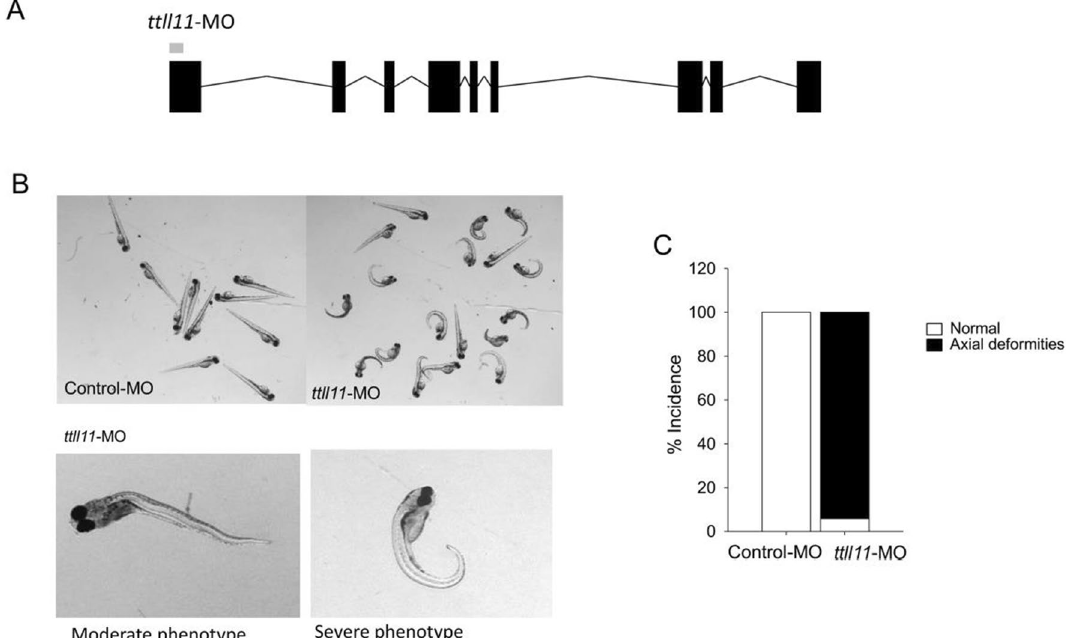
Figure 5. Knockdown of ttll11 leads to scoliosis phenotype in zebrafish larvae. Ttll11 knock-down zebrafish showed body curvature phenotype compared to control. ( A ) Representation of the blocking antisense morpholino oligonucleotide targeting zebrafish ttll11 (NM_001077375.1). ( B ) Mutant and control zebrafish phenotype (3–5 dpf). ( C ) Incidence of body axial deformity after MOs injection into fertilised zebrafish eggs at the one- to two-cell